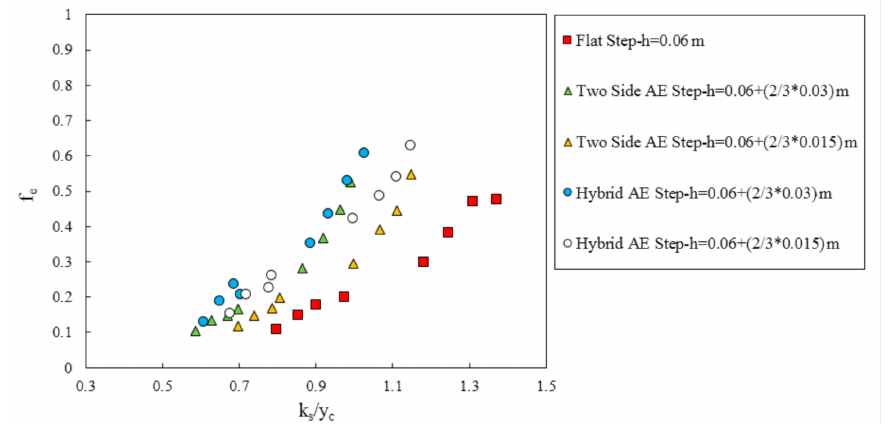
Figure 20. The effect of the appendance elements height on the friction